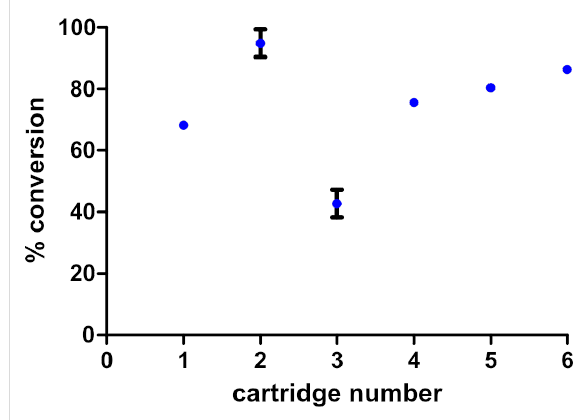
Figure 5: Cartridge-to-cartridge variability of the substrate conversion based on the reduction of styrene to ethylbenzene. All reactions were carried out at 2.0 M in MeOH, at a flow rate of 1.0 mL/min, at 30 °C, with 1.9 mL per injection, and 10 mL product solution collected; n = 3 experiments for each cartridge. The conversion was determined by GC–MS analysis with decane as an internal standard. Commercial 10% Pd/C 30 mm CatCart ® cartridges were used; numbers 1, 2, and 3 from lot #02946; numbers 4, 5, and 6 from lot